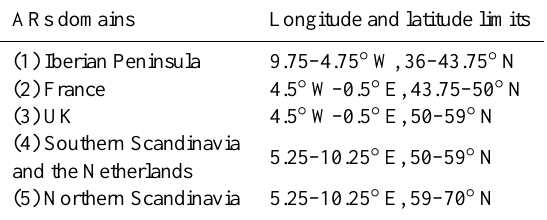
Table 4. 90th percentile for the anomaly values of the ( E − P ) > 0 field [( E − P ) An ] for each studied domain and longitude (in mmday − 1